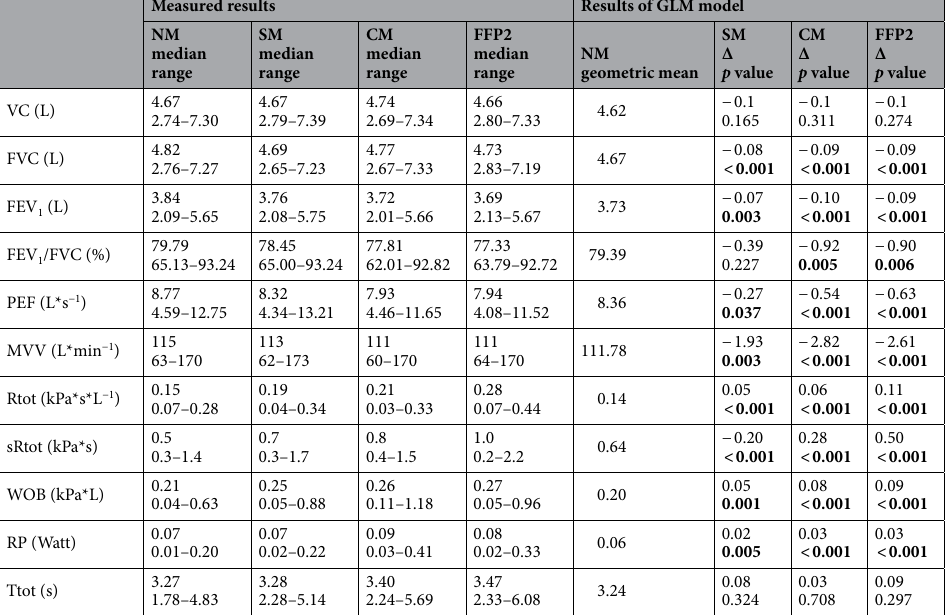
Table 2. Body plethysmography results of 40 subjects tested without mask (NM) and with three different mask types (SM, CM, FFP2) using the mask adapter. CM Community mask, Δ Difference to NM, FEV 1